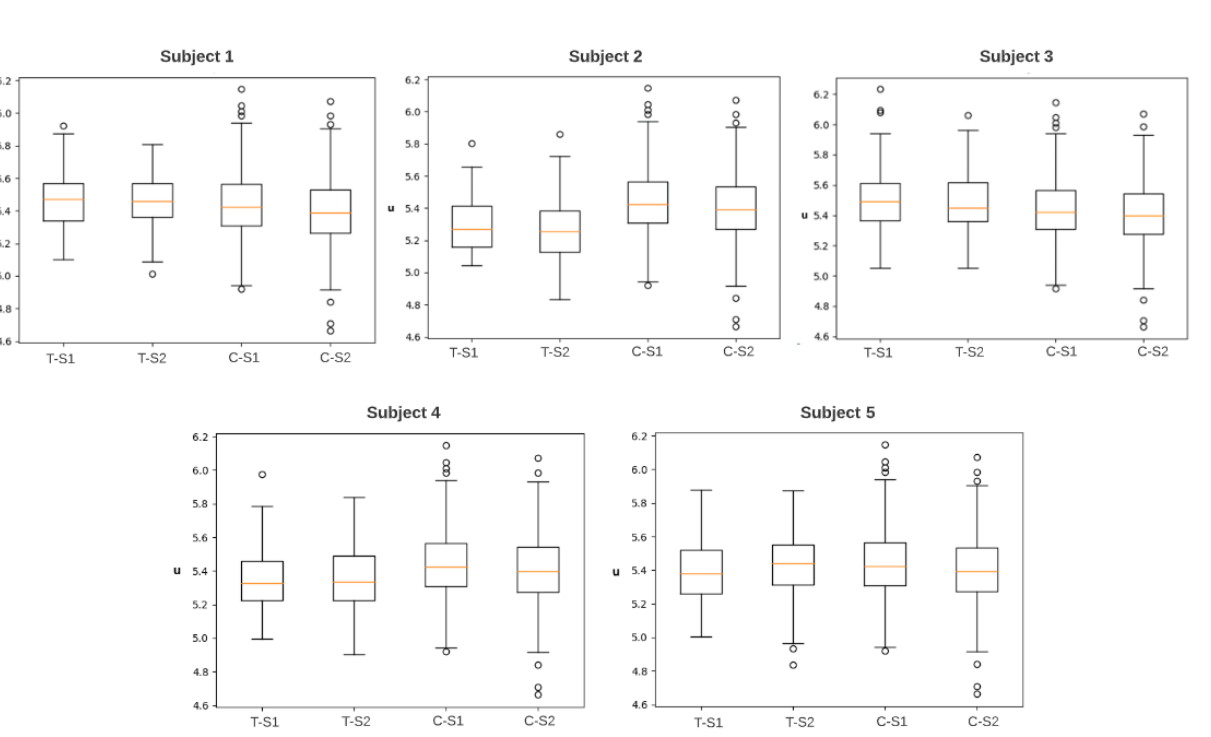
In Figure 7, boxplots display the distribution of the different study datasets: tinnitus and control groups in two monitoring sessions: before and after the sound-based treatment.